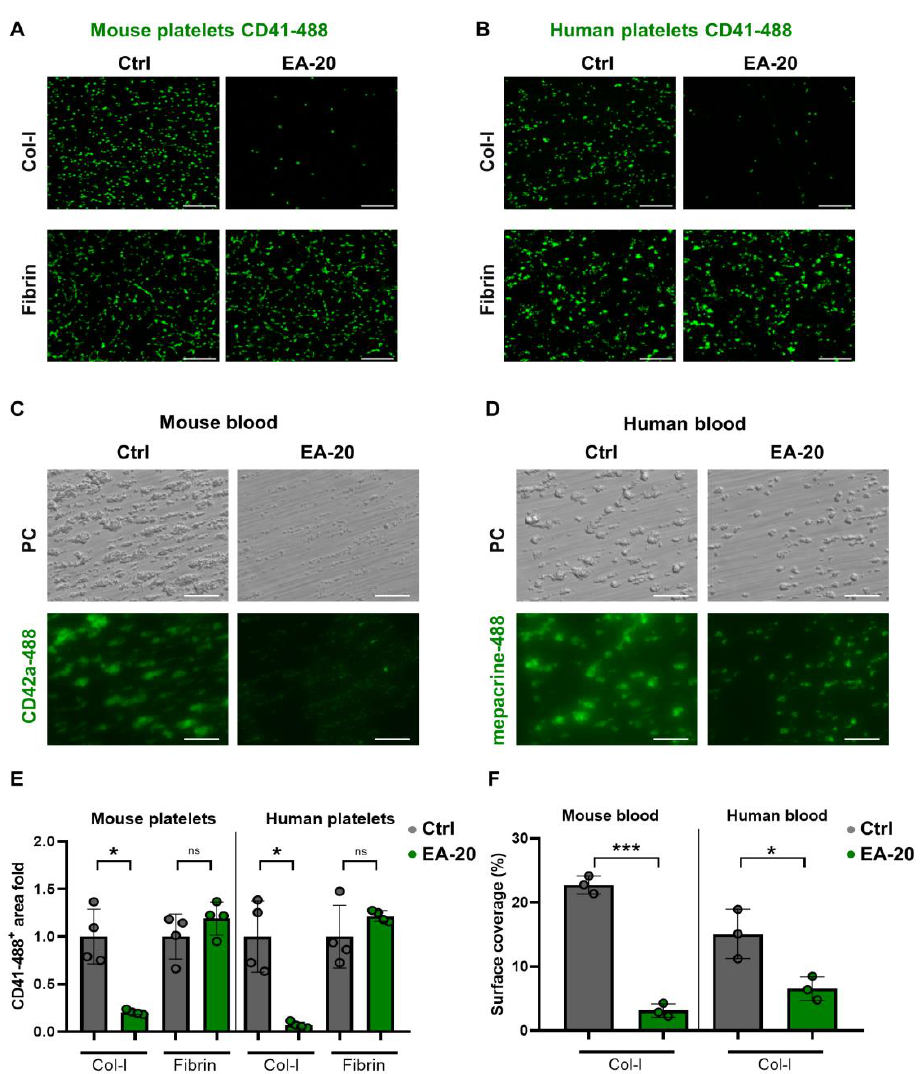
Figure 3. EA-20 antibody selectively impairs platelet adhesion and thrombus formation to Col-I- coated surfaces under static and flow conditions. Representative immunofluorescence and phase contrast microscopy images of mouse and human platelets adhering to Col-I and fibrin under ( A , B ) static and ( C , D ) flow conditions, r espectively. Scale bar: 20 μm. Washed ( A ) mouse and ( B ) human platelets were allowed to adhere to Col-I and fibrin-coated glass coverslips in the presence of an IgG control (Ctrl) and or EA-20 antibody. After 1 hour, adherent cells were fixed, stained with an anti- CD41-488 antibody, and observed by immunofluorescence confocal microscopy. Anticoagulated mouse (heparinized, C ) and human (citrated, D ) whole blood, stained with anti-CD42a-(DyeLight)- 488 or mepacrine salts, were perfused over Col-I-coated glass slides at 1000 s -1 shear rate in the flow chamber in the presence of control IgG (Ctrl) and or EA-20 antibody and monitored for 5 minutes. ( C , D ) Representative phase contrast (upper panel) and fluorescence microscopy (lower panel). PC (Phase contrast). Scale bar: 10 μm. ( E , F ) Quantification of surface coverage of fluorescent signal cor- responding to the amount of adherent platelets and or thrombus formation. ( E , F ) Mean ± standard deviation (SD), Ctrl (IgG control antibody) and EA-20. ( E , F ) Each point represents one individual mouse or healthy human donor. ( E , F ) Mann – Whitney U test, * p < 0.05; unpaired t test, *** p < 0.001 and * p < 0.05; ns, not significant.